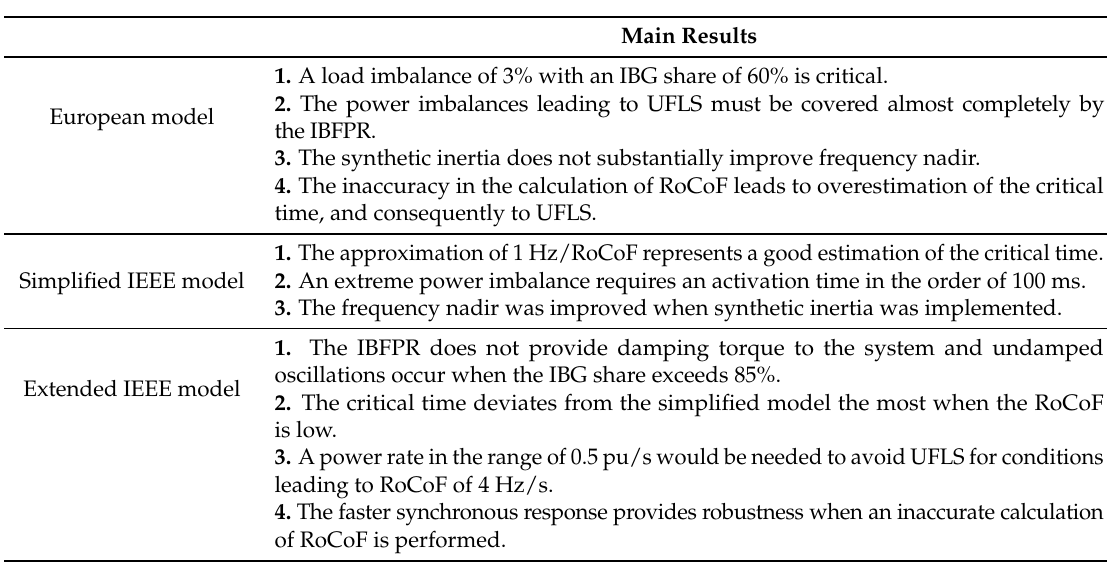
Table 8. Summary of